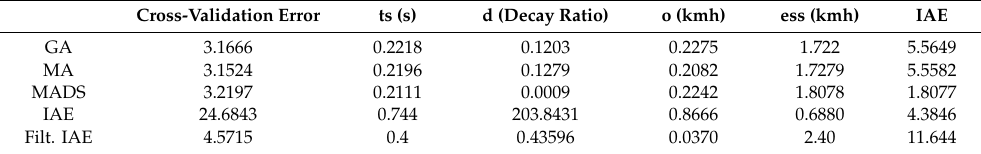
Table 3. Sensitivity analysis of the model against changes in the weight of the